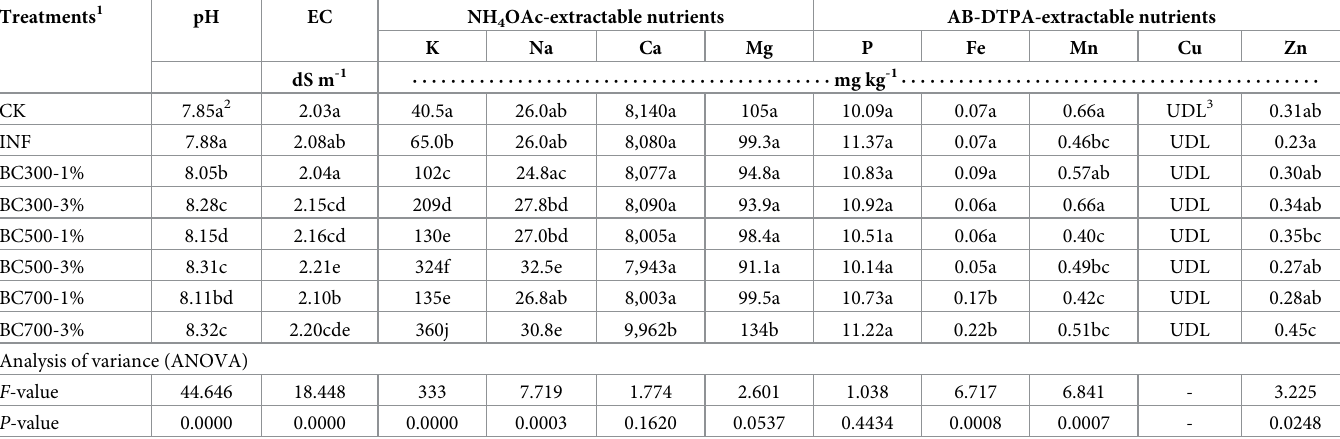
Table 4. The influences of the applied Olive Mill Solid Waste-derived Biochars (OMSW-BCs) on the soil pH and EC, and the soil concentrations of NH 4 OAc- and Ammonium Bicarbonate-DiethyleneTriaminePentaacetic Acid (AB-DTPA)-extractable nutrients. Treatments